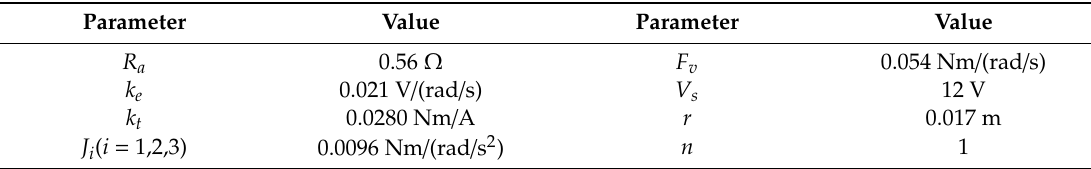
Table 3. Parameters of the driver motors.